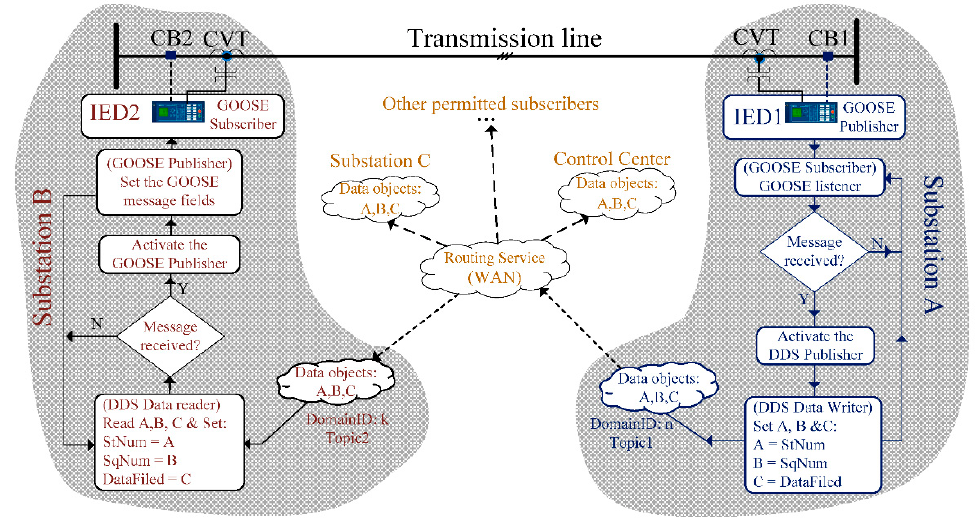
Figure 1. Proposed data-centric communication framework for multicast routable generic object-oriented substation event messages (MRGM).